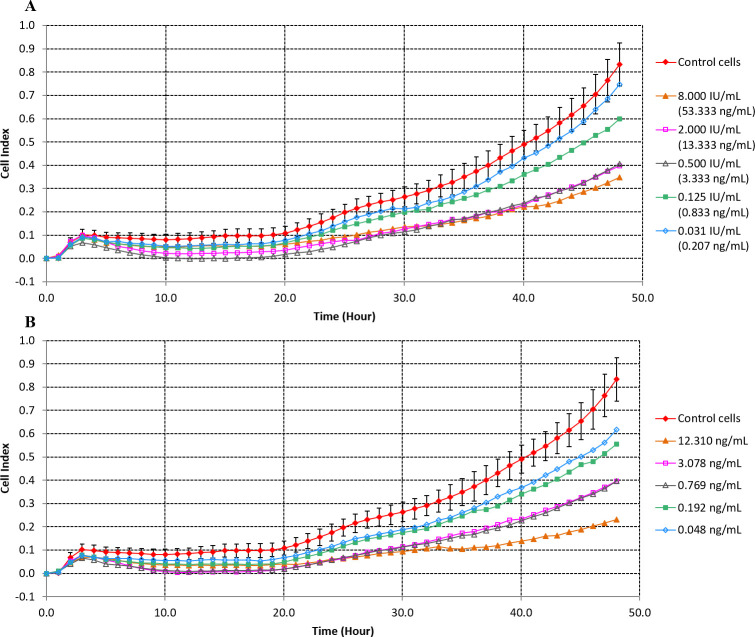
Cell index in real time after treatment of CHO cells with variable concentrations of pertussis toxin.(A) Treatment with standard pertussis toxin. (B) Treatment with in-house pertussis toxin. Control cells were incubated with culture medium only. Results of one representative experiment are shown [n = 1 for all pertussis treatment and n = 6 for the cell controls (Average of cell control represented)]. Error bars represent standard deviations.